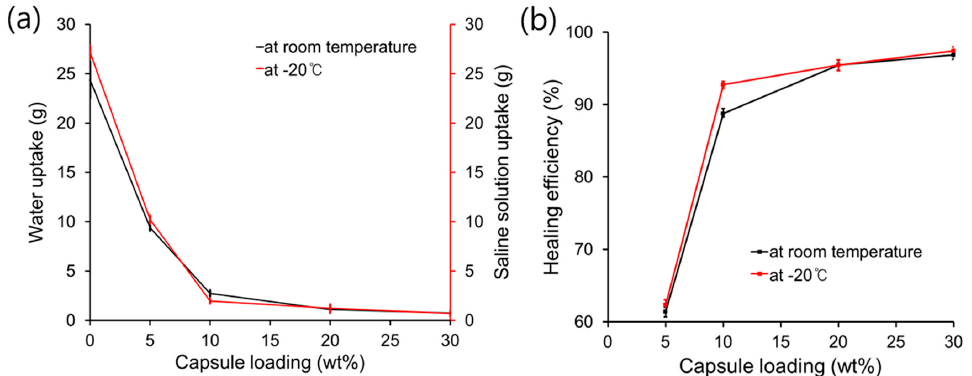
Figure 7. ( a ) Water or saline solution uptake versus capsule loading for coated mortar specimens; ( b ) Healing efficiency versus capsule loading of the self-healing coatings calculated using Equation (2) and data from Figure 7a.